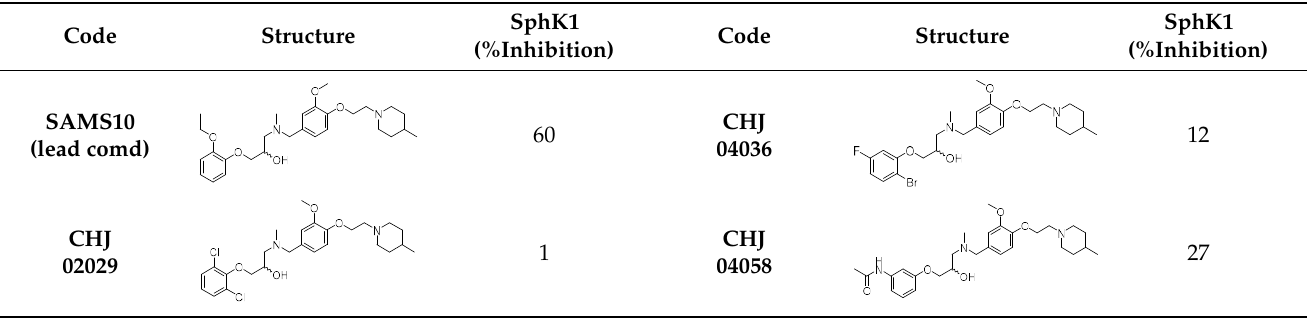
Table 2. Percent inhibition of CHJ series compounds (10 μM) on SphK1.